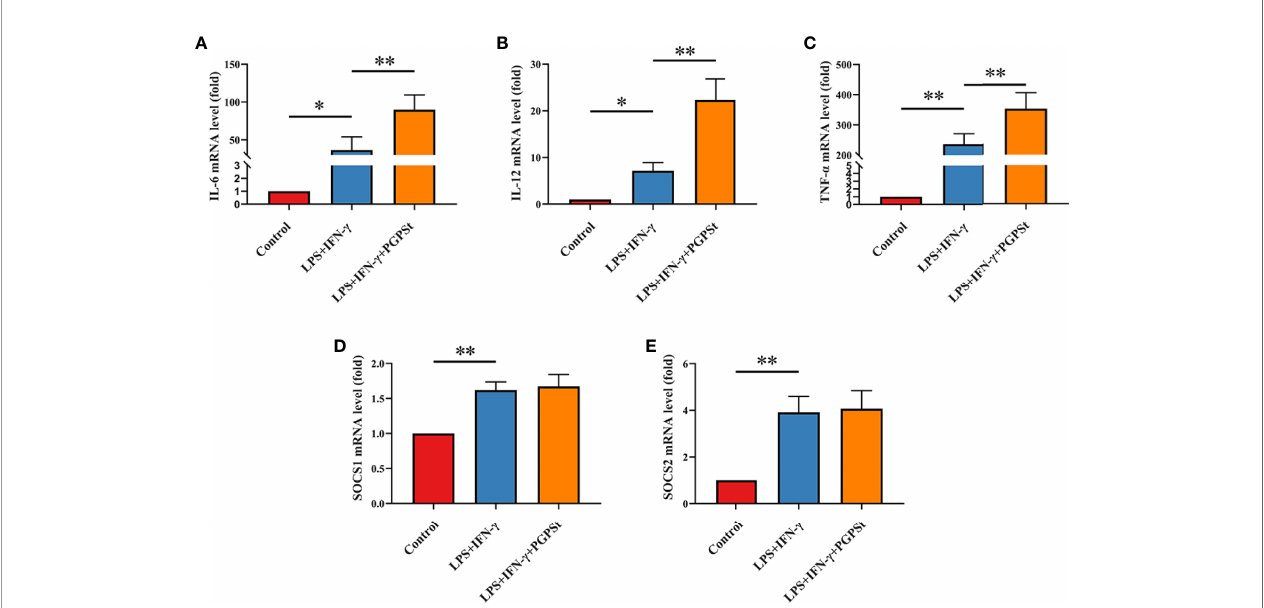
FIGURE 2 | qRT-PCR analysis to determine 3D4/21 cell polarization. After treatment with various reagents, the mRNA levels of M1-type 3D4/21 cells were monitored by qRT-PCR. After incubation for 24 h, these images showed the expression of polarization markers in M1-type 3D4/21 cells, such as (A) IL-6, (B) IL-12, and (C) TNF- a . The expression of regulatory factors (D) SOCS1 and (E) SOCS2 in the polarization pathway of M1-type 3D4/21 cells. Means ± SD are indicated (n = 3). * indicates P < 0.05; ** indicates P <